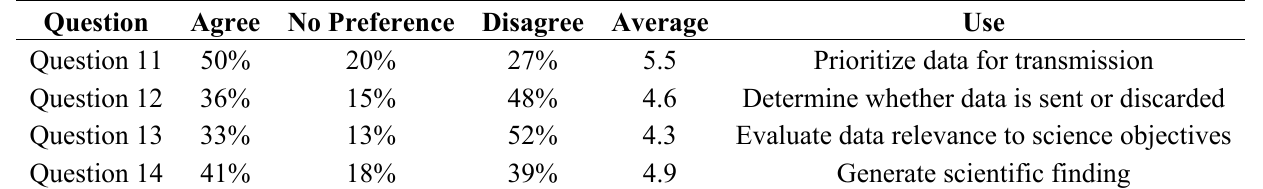
Table 18. Summary of respondent preferences for Questions 11 through 14.